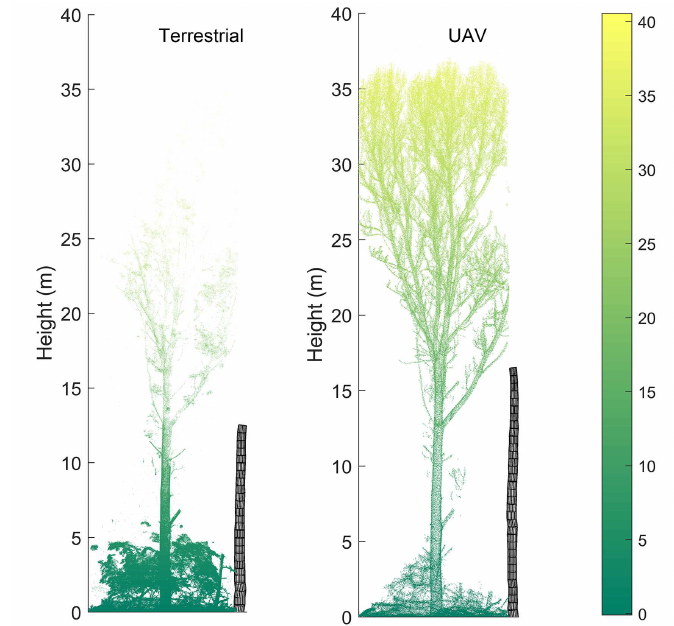
Figure 17. An example of our method applied to a deciduous tree. The point cloud was acquired from TLS and UAV laser scanning,